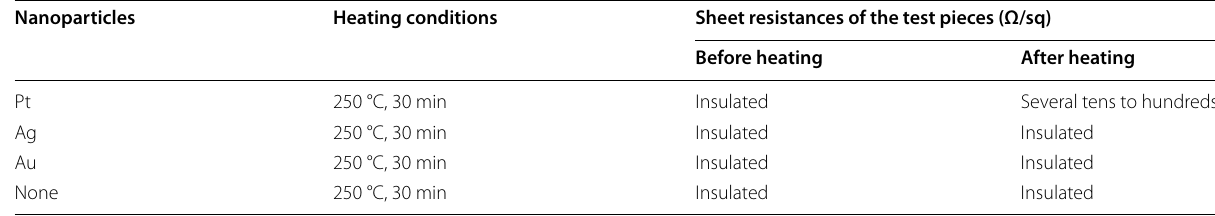
Table 1 Sheet resistance variations of the test pieces with different metal nanoparticles Nanoparticles Heating conditions Sheet resistances of the test pieces (Ω/sq) Before heating After heating 250 °C, 30 min Insulated Several tens to